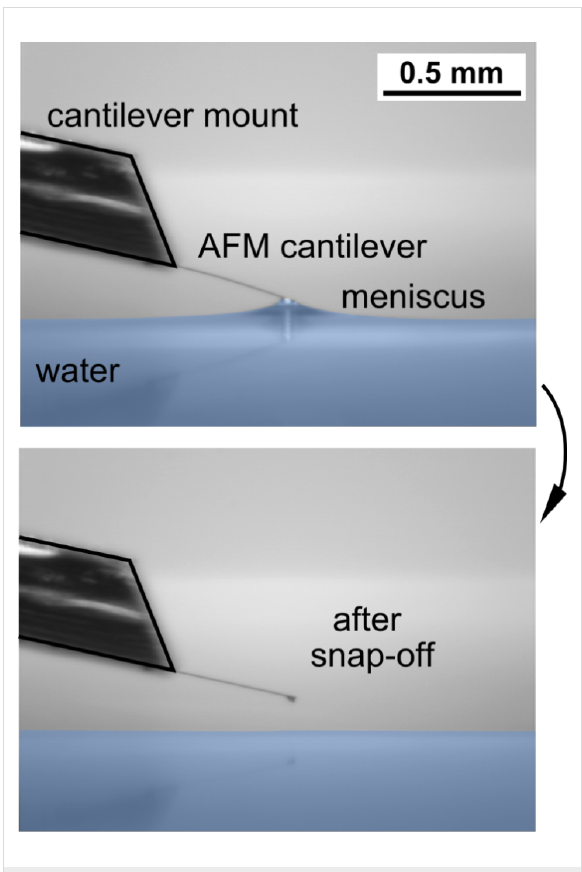
Figure 5: Proof of concept and accuracy of CAT, using specially cali- brated AFM cantilevers. Determining the spring constant of the cali- brated cantilever using the same settings as used for the individual hairs (see above, Figure 4) yields a spring constant in agreement with that given by the